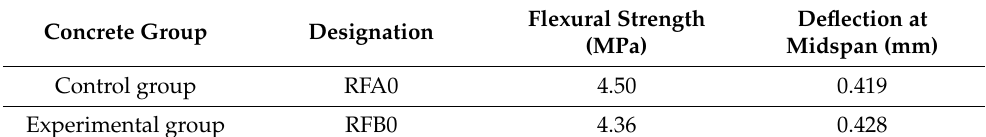
Table 17. Results of flexural test of the concrete at room temperature.